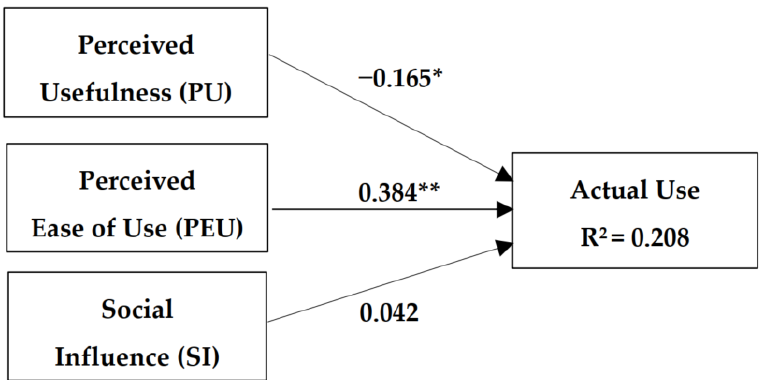
Figure 2. Model 2: The model includes perceived usefulness, perceived ease of use, and social influences as independent variables. The presented model explained 20.8% of the actual use of virtual clinics. However, the beta for the SI variable was not statistically significant. * p < 0.05; ** p < 0.001.